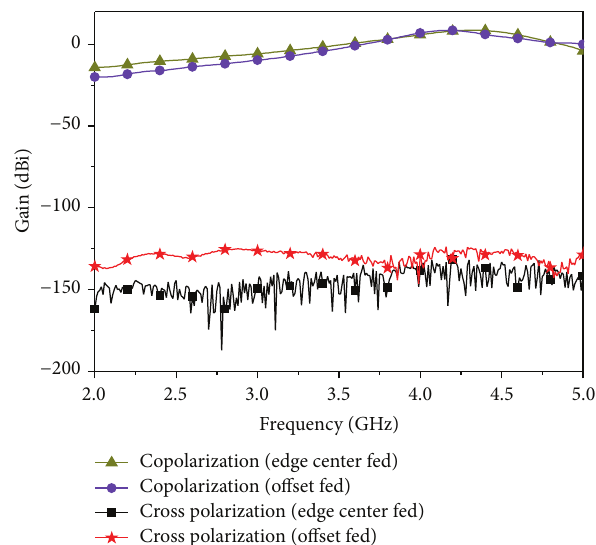
Figure 12: Gains in the main beam direction calculated by copo- larization and cross-polarization field components of the symmetry offset fed and edge center fed patch antennas as functions of frequency.